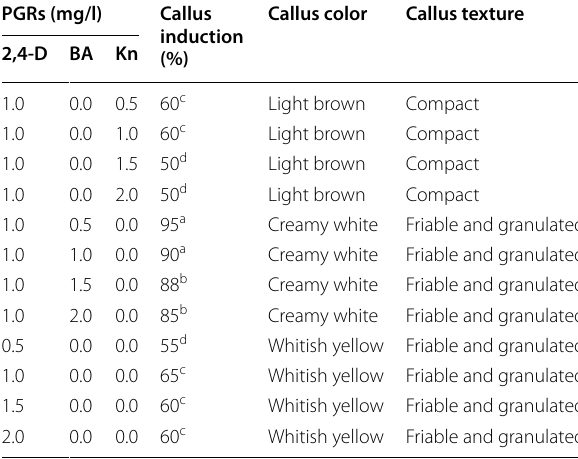
Table 1 Effect of different concentrations of plant growth regulators (PGRs) on callus induction from stem explants of